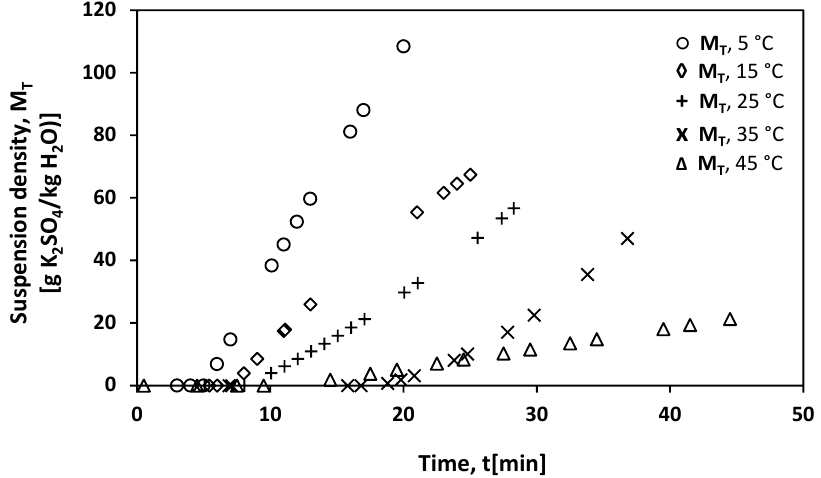
Figure 9. Suspension density of K 2 SO 4 as a function of time at different S 0 generated by reactive crystallization isotherms at 5, 15, 25, 35 and 45 °C.